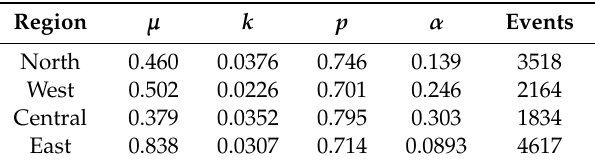
Table 11. Parameter estimates for the parameters µ , k , p and α of the ETAS model. The values are the values from the ‘Best Value’ columns in Tables 7–10. The last column gives the number of events in the study period.